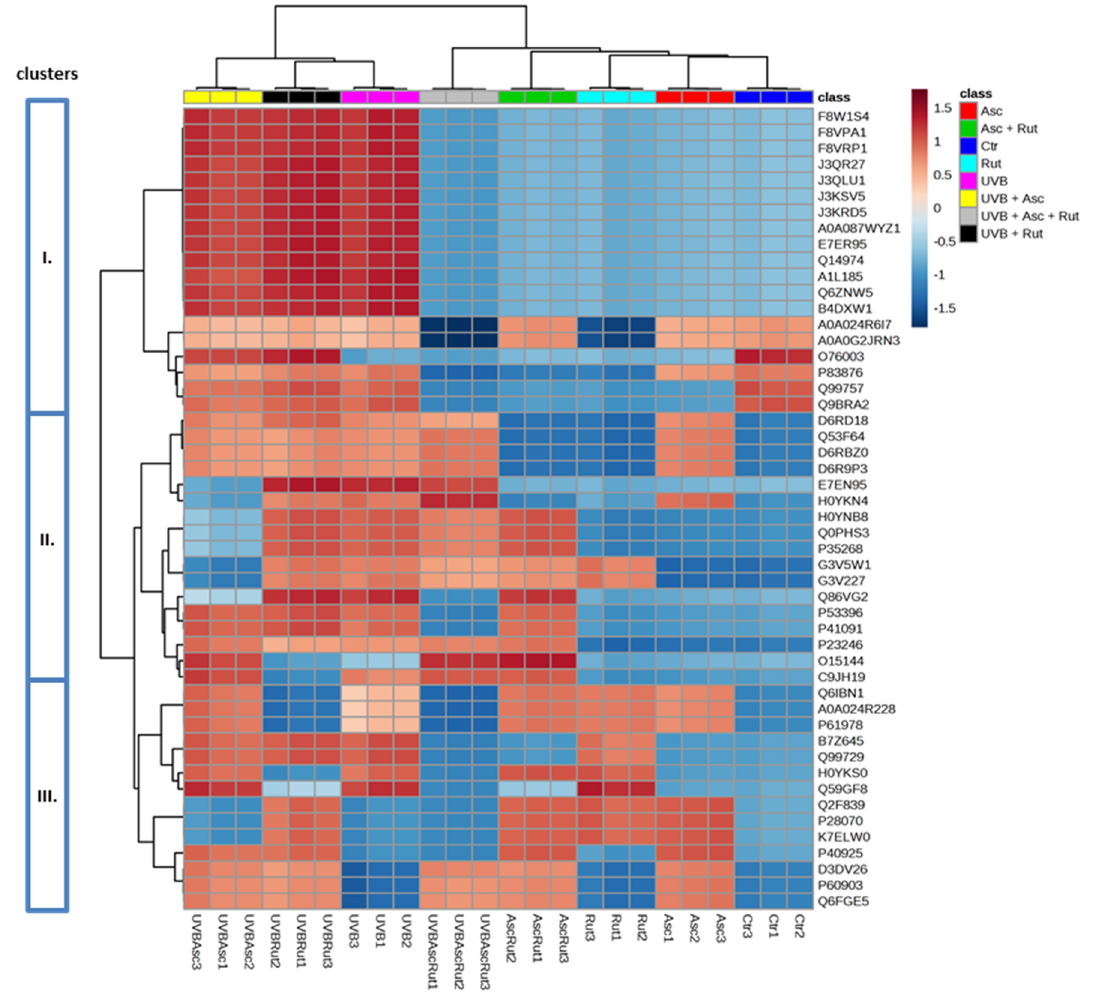
Figure 2. Heat map and clustering for the top 50 proteins from the 3D cultured fibroblasts exposed to UVB irradiation (200 mJ/cm 2 ) and treated with ascorbic acid [100 μ M] and/or rutin [25 μ M]. Protein expression levels (log transformed) were scaled to the row sum. Abbreviations: Asc, ascorbic acid; Rut, rutin; Ctr, control. Analysis made using MetaboAnalyst 4.0.